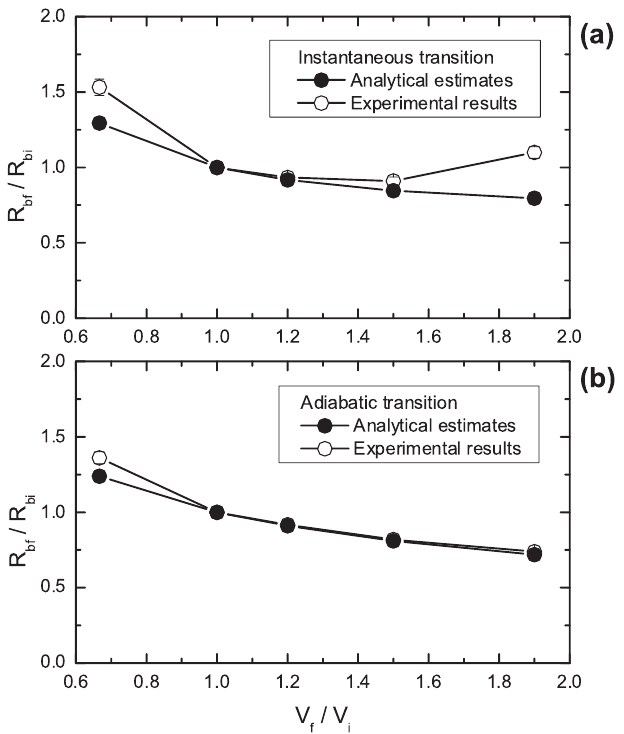
=R FIG. 9. Plots of the ratio of final to initial rms radius R bf bi =V =R for different values of V . The values of R are either f i bf bi estimated based on analytical theory (solid circles), or inferred from experimental data (open circles). The two cases correspond to (a) instantaneous transitions, and (b) adiabatic transitions. (cid:2) 49 : 8 (cid:3) and f (cid:2) 60 kH z Here, (cid:5) sf vi